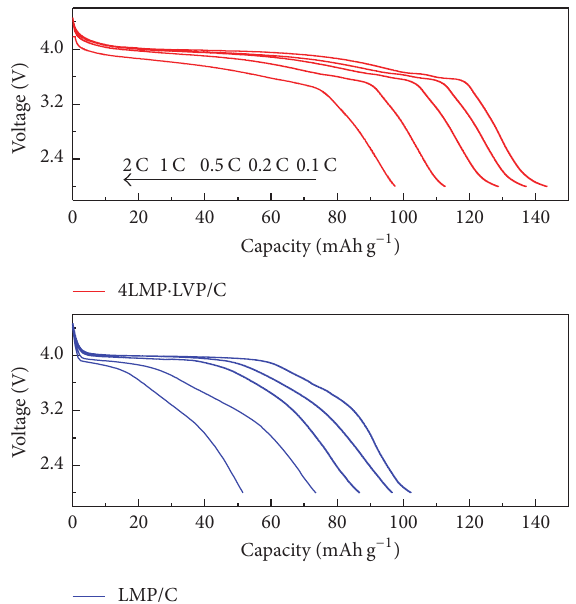
Figure 4: The charge-discharge capacity profiles (a) and cycle life profiles (b) of x LMP ⋅ y LVP/C at 0.1 C.